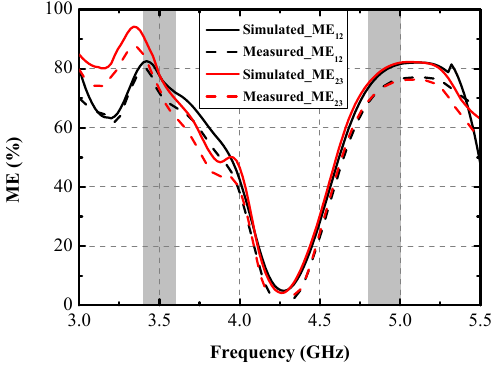
Figure 15. Simulated and measured MEs.